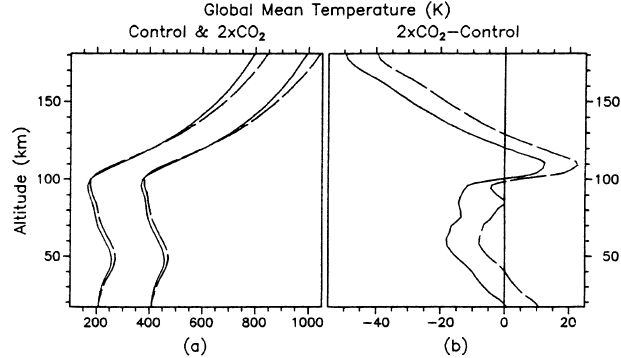
Fig. 12. As in Fig. 11 but as a function of